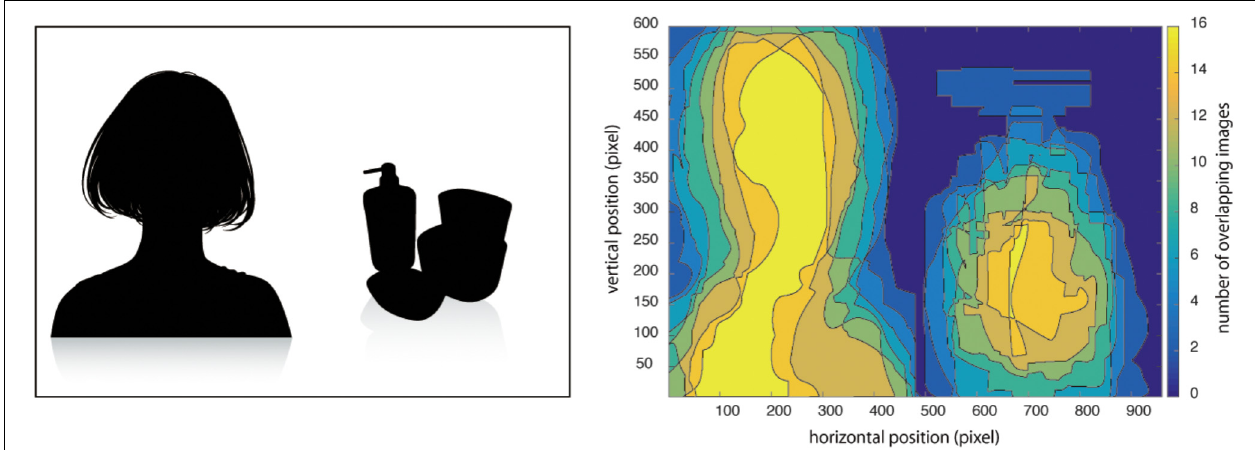
FIGURE 1 | A schematic illustration (left) and the contour graph (right) of the advertising images used in the experiments. To create the contour graph, advertising images in which a female model was located on the right side of the image were reflected along the vertical axis. Then all pixels of each image were binarized (0 as the background containing neither a female model nor a product and 1 as the area containing either the model or the product) and all images consisting of binary values were combined into the image of the contour graph. The higher (lower) contour value and more yellowish (bluish) colors indicates areas that had the greater (lesser) overlap of female models or products across the images.